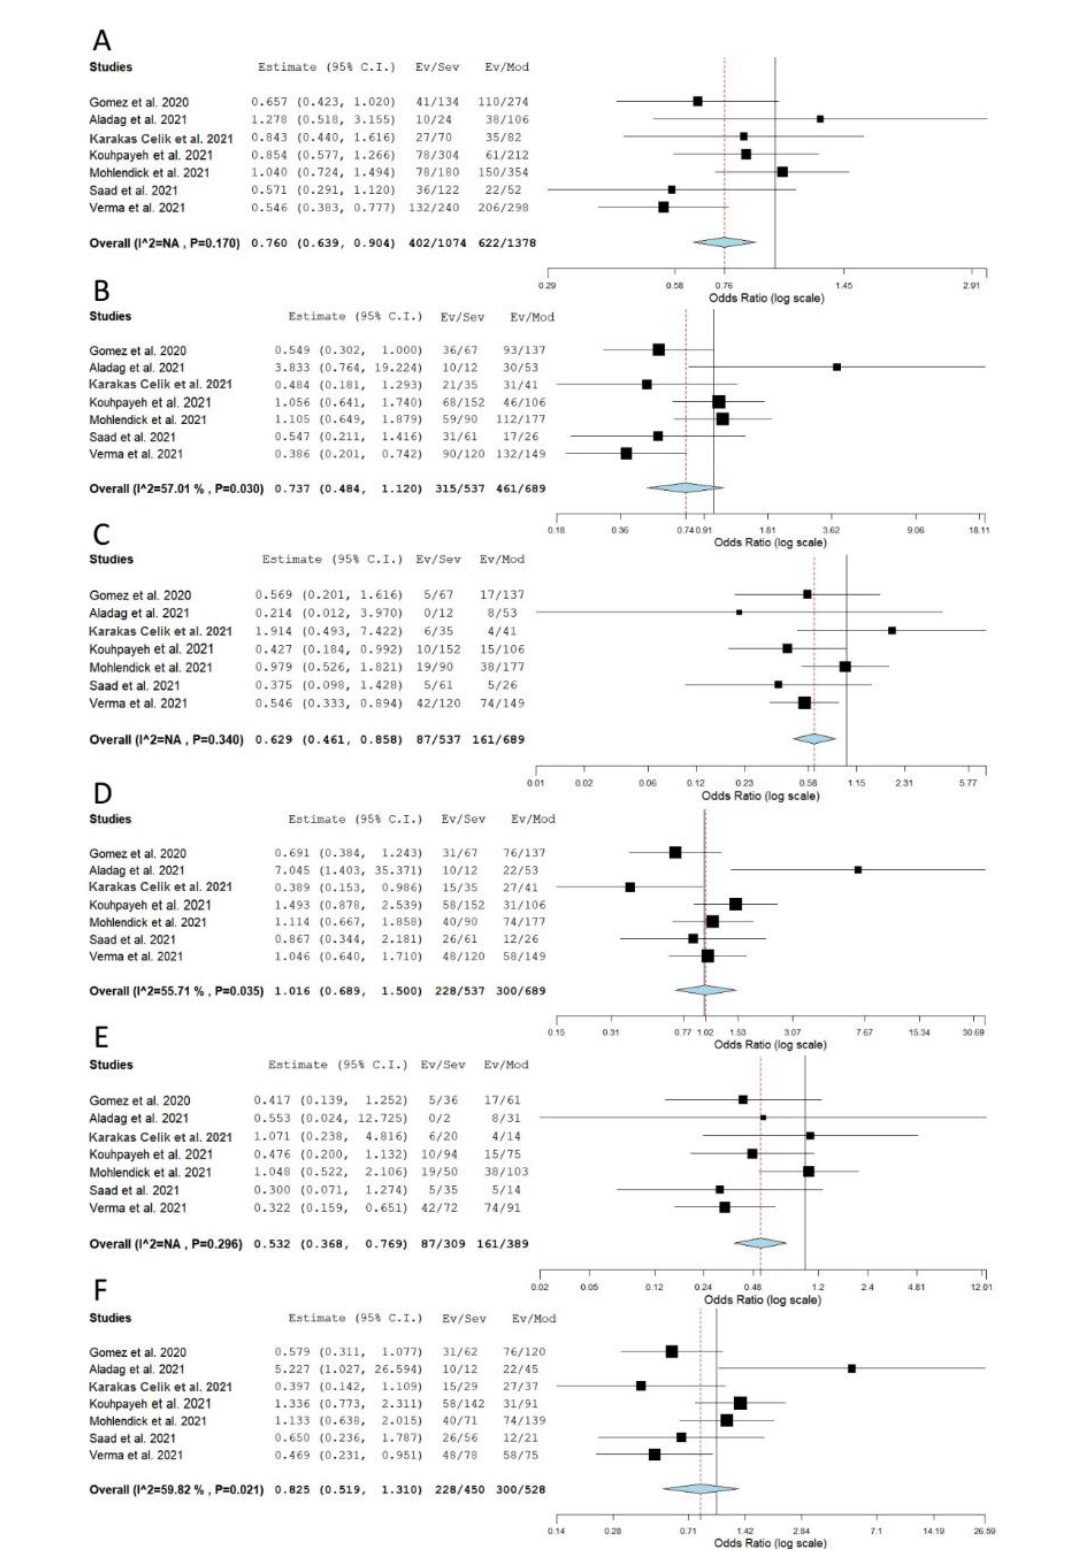
Figure 3: Meta-analysis of the association between rs1799752 in ACE1 and COVID-19 severity: com- parison severe vs. moderate. A ) allelic model; B ) dominant model; C ) recessive model; D ) overdomi- nant model; E ) II vs. DD; F ) DI vs. DD. The results of the included studies presented as ORs, with 95 % CI, and the overall effect with 95 % CI are shown in the forest plot. P values given are derived from heterogeneity